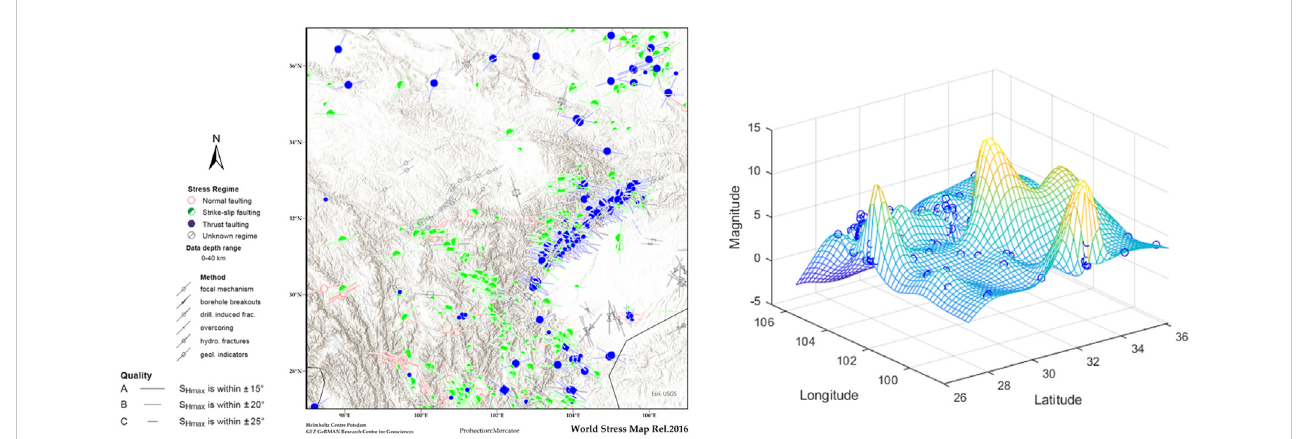
FIGURE 9 Left subplot is stress map of the study area (the data are provided by http://www.world-stress-map.org/); right subplot is 3D seismic belts – earthquake distribution map; there are three seismic belts, including the Western Yunnan belt, Western Yunnan belt, and Anning river